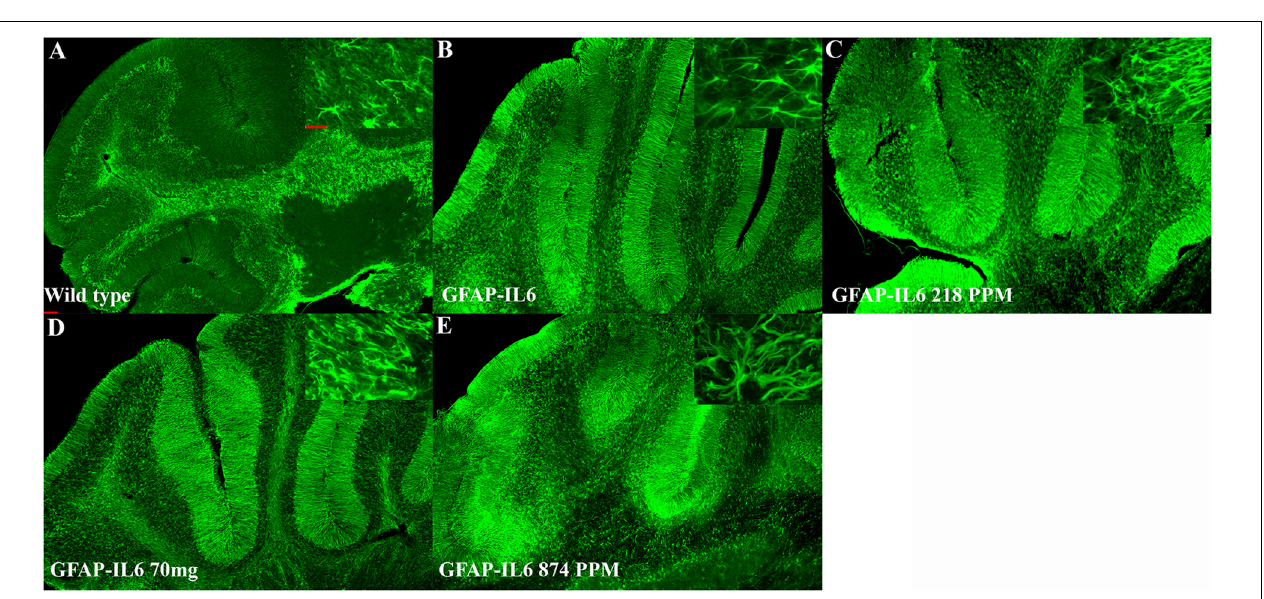
FIGURE 6 | MC decreased GFAP + astrocytes in the cerebellum of GFAP-IL-6 mice. Representative photomicrographs of immunofluorescence staining for the astrocytes (GFAP + cells) in the cerebellum. (Magnification 5x and 63x objective field, scale bar = 100 µ m in 5x and 50 µ m in 63x). Images are representative of at least six animals per group ( n =